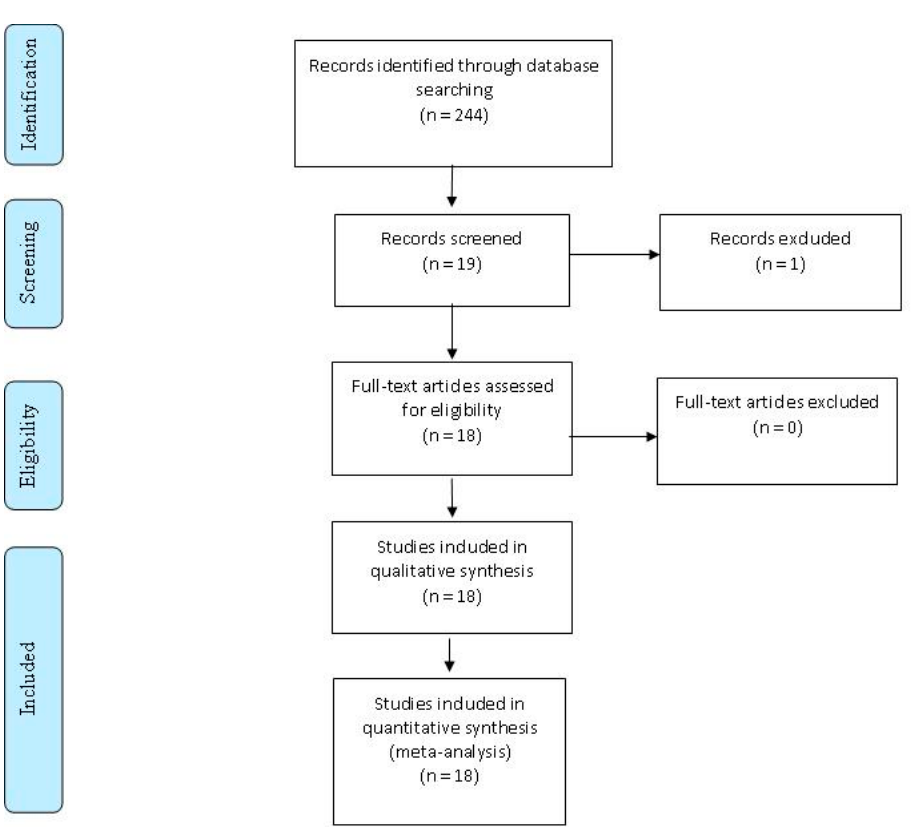
Figure 1. Flow diagram of the literature review. This detailed flow diagram depicts the search and selection processes.